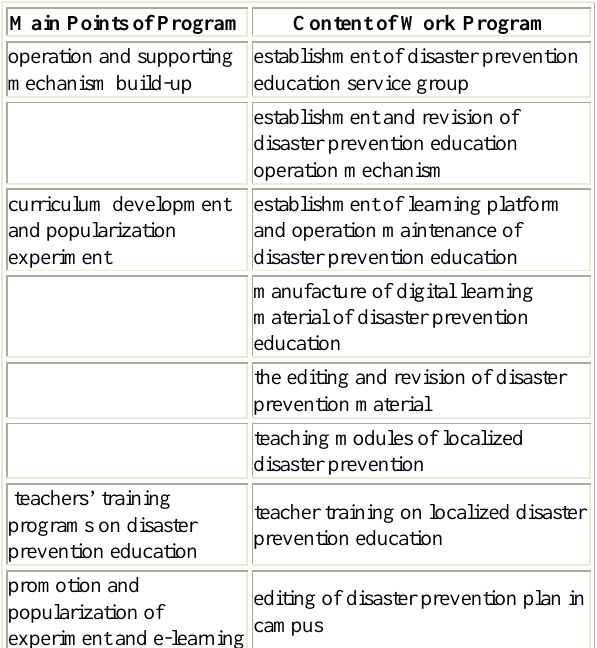
Table.1 Working Plan